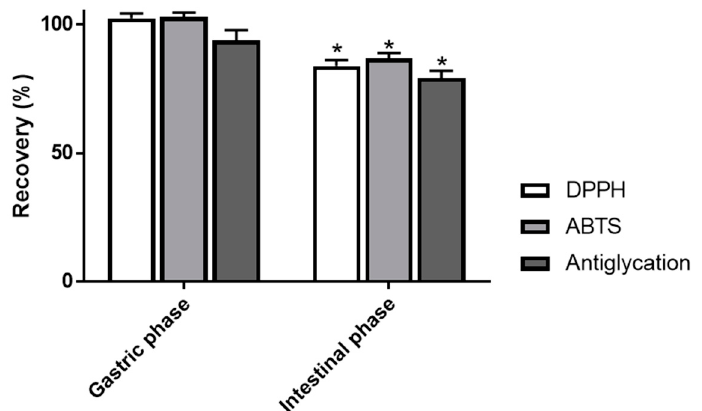
Figure 6. Recovery index of radical scavenging (DPPH, ABTS) and antiglycation activities of Vaccinium myrtillus fruit extract after each step of in vitro gastrointestinal digestion. Values are presented as means ± SEM ( n = 3). * p < 0.05 vs. control (undigested matrix). DPPH: 2,2-diphenyl-1-